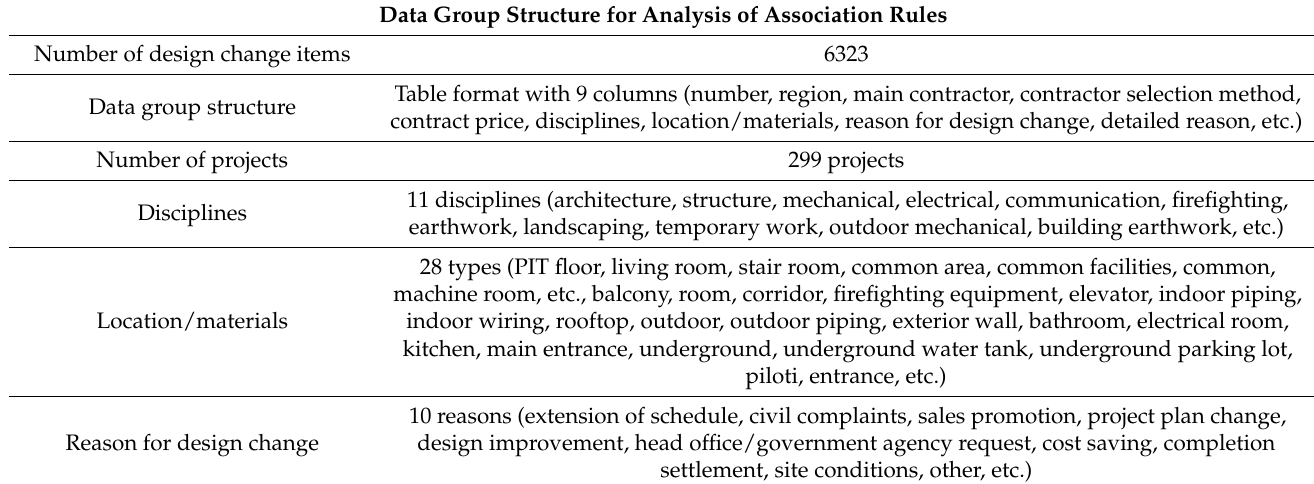
Table 2. Association rule analysis input data structure.